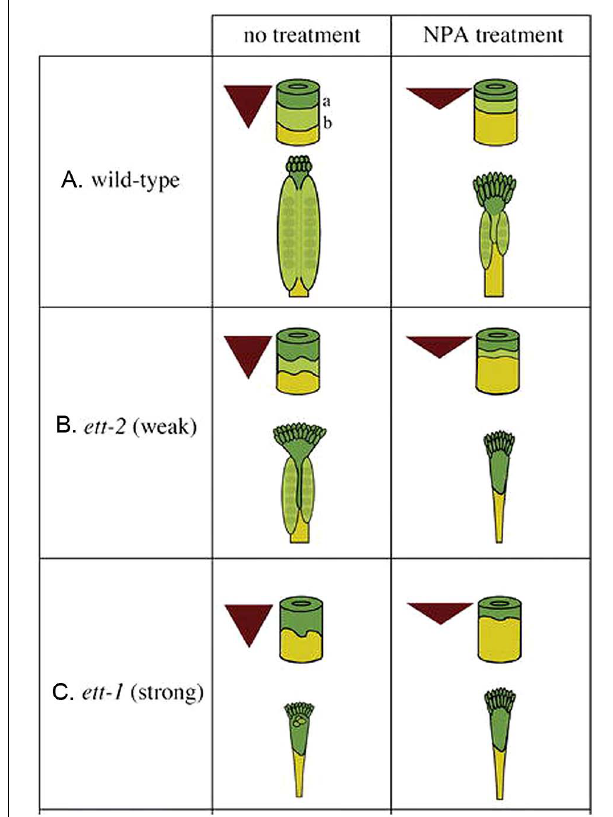
FIGURE 3 |The auxin gradient model. Auxin is produced at the apex and transported toward the base, creating a morphogenic gradient that provides positional information, which is interpreted in part by ETT to specify ovary valve.The triangle represents the auxin gradient within the gynoecium.The cylinder represents the gynoecium with border marked “a” between the style (dark green) and ovary (light green) and border marked “b” between the ovary and gynophore (yellow). (A) Wild-type gynoecia with and without NPA treatment. (B) Weak ett-2 mutants with a mild phenotype (left); the phenotype is significantly enhanced when ett-2 mutants were treated with NPA (right). (C) Strong ett-1 mutants with a strong phenotype with or without NPA treatment.The figure is reproduced from Nemhauser etal. (2000) with permission from Copyright Clearance